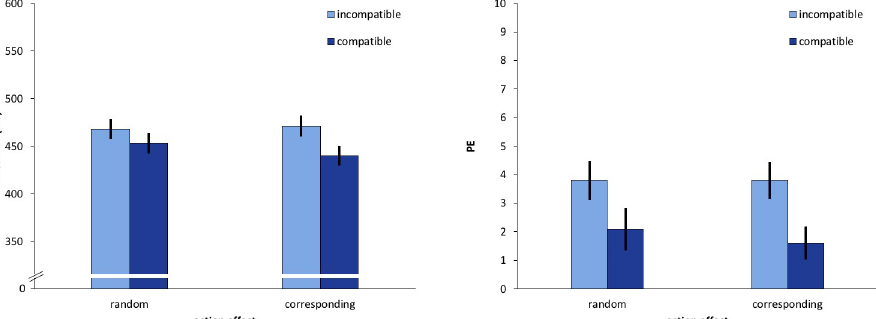
Fig 4. Results of Experiment 2. Mean Reaction times (RT) in ms (left) and percentage errors (PE, right) as a function of avatar compatibility and action effect. Error bars represent 95% within-subject CIs